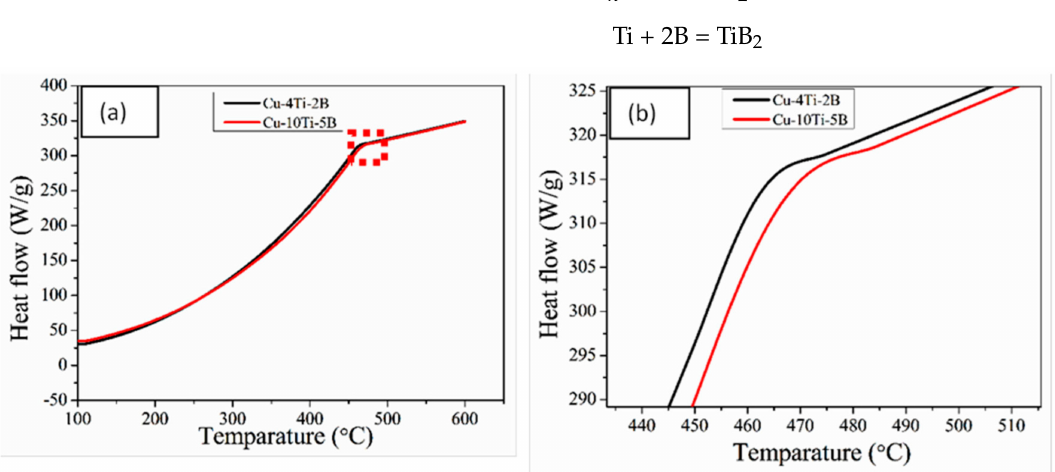
Figure 9. ( a ) DSC curve of the two types of alloy composite; ( b ) zoom of the red block